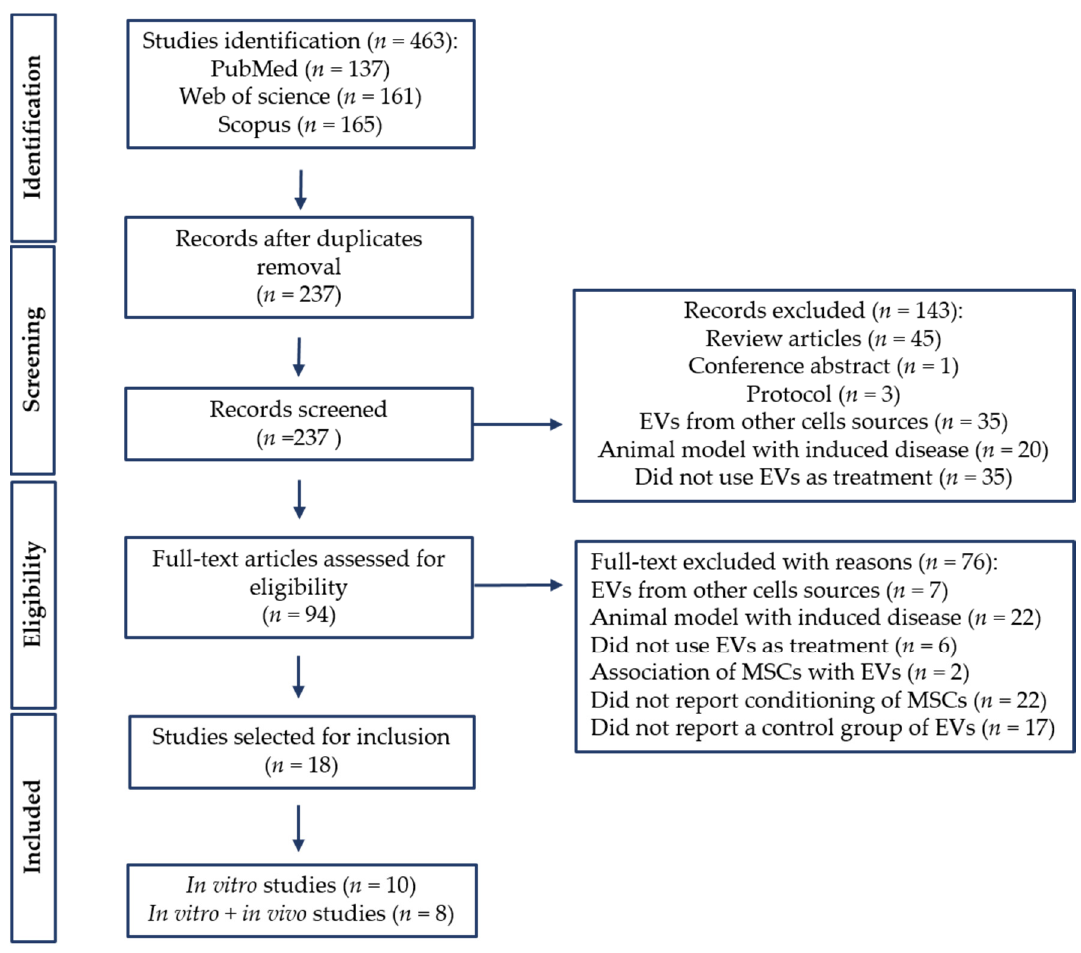
Figure 1. PRISMA flow diagram of literature search and selection process. PRISMA, Preferred Reporting Items for Systematic Reviews and Meta-Analyses.